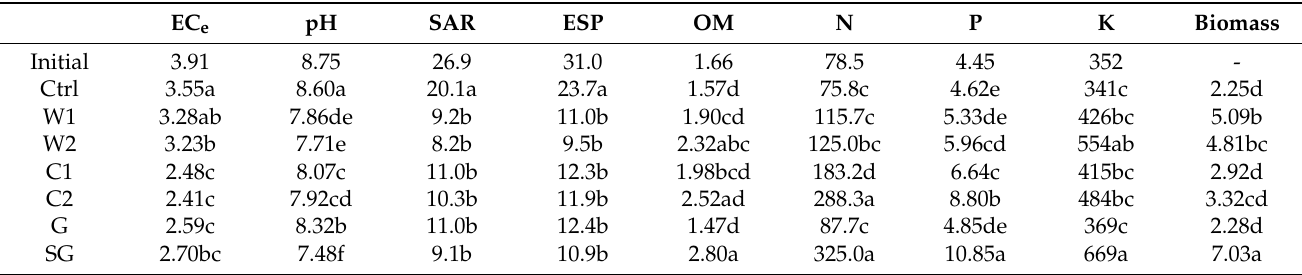
Table 2. Change in EC e (ds m − 1 ), soil pH, SAR, ESP (%), OM (%), soil available N, P, K (mg kg − 1 ), and biomass (g pot − 1 ) after soil incubation with various treatments. Same letters within columns indicate no significant differences ( p < 0.05, Tukey’s